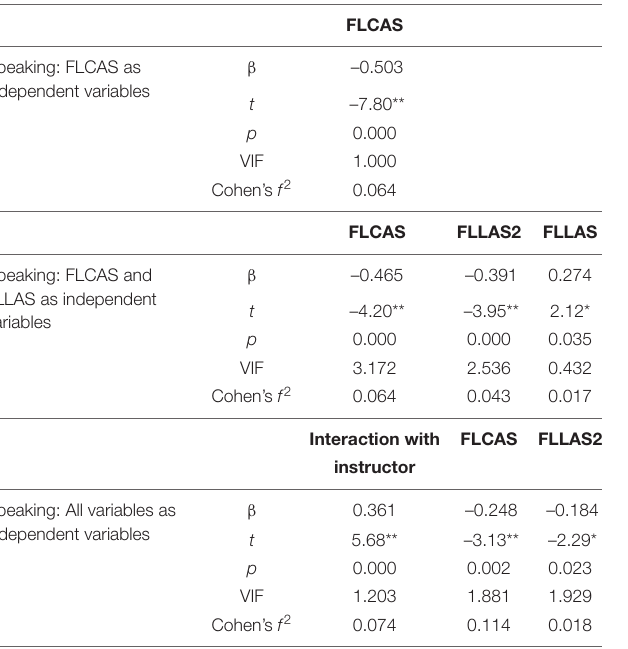
TABLE 6 | Multiple regression coefficients and significance of predictors for listening English proficiency (phase